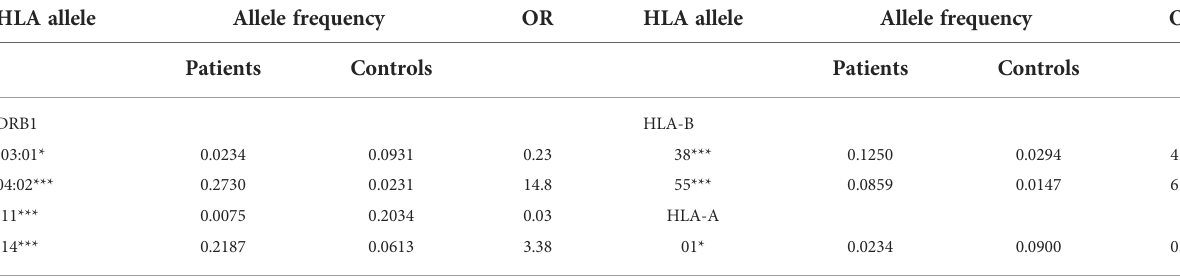
TABLE 3 HLA alleles signi fi cantly associated with PV in the Bulgarian population. HLA